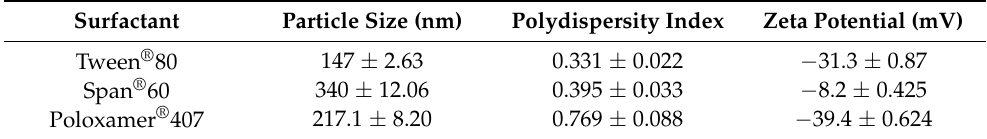
Table 2. Pre-formulation non-ionic surfactants screening.